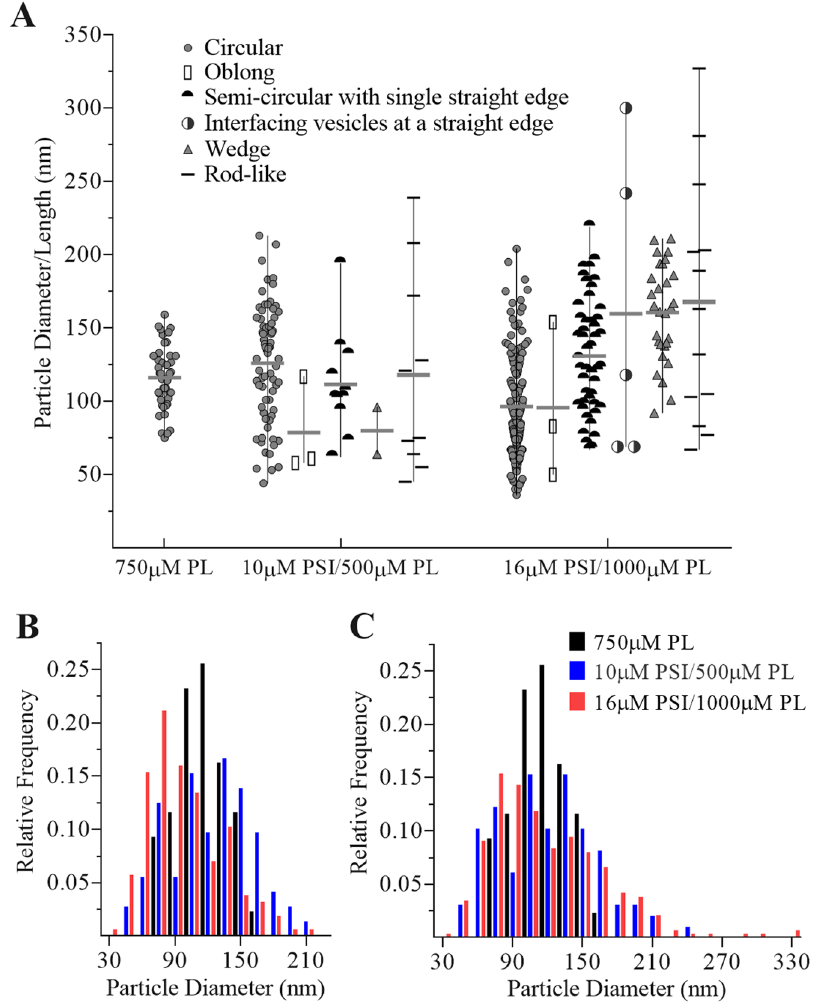
Figure 8. Summary of cryo-TEM image morphological phenomena. ( A ) Enumeration and comparison by size of vesicle morphologies as identified in the legend; ( B ) histogram comparison of circular vesicle size distributions; and ( C ) histogram comparison of all vesicle morphologies’ size distributions. Note that results are derived from images not limited to the selected examples in Fig. 8, and exclude vesicles in contact with the sample